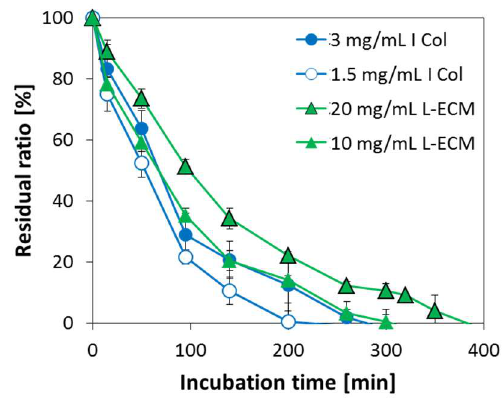
Figure 9. Degradation profiles of I Col gels (3 and 1.5 mg/mL) and L-ECM gels (20 and 10 mg/mL) using collagenase solution at a concentration of 0.05 mg/mL as a function of incubation time ( n = 3, bars represent standard deviation).